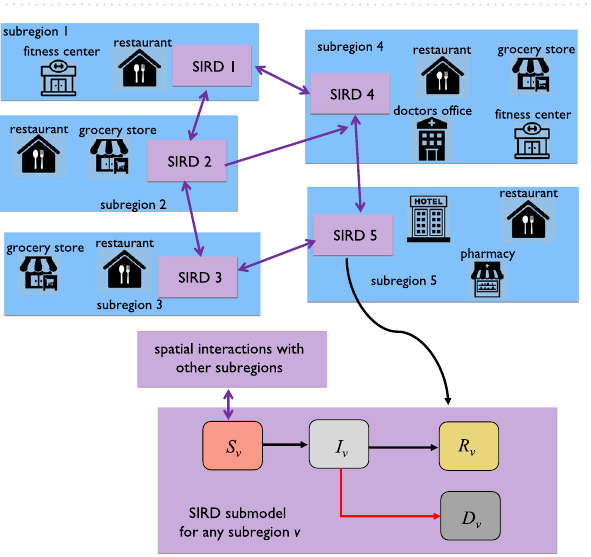
Figure 1. Left: Visualization of the multiple scales of pandemic control strategy synthesis. Right: Resulting SIRD dynamics for the considered MSAs. The y-axes denote the cumulative number of infected people in millions, and x-axes denote the time in days. The blue and red curves visualize the cumulative number of infected people with and without an optimal lockdown policy, respectively.